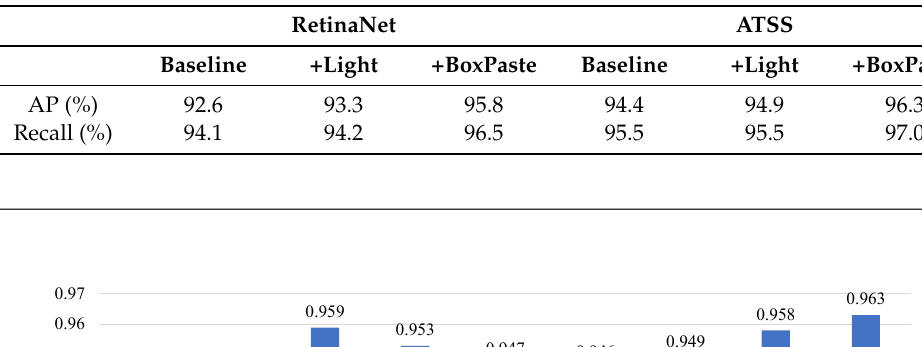
Table 4. The effects of light head/FPN and BoxPaste on RetinaNet and Adaptive Training Sample Selection (ATSS).